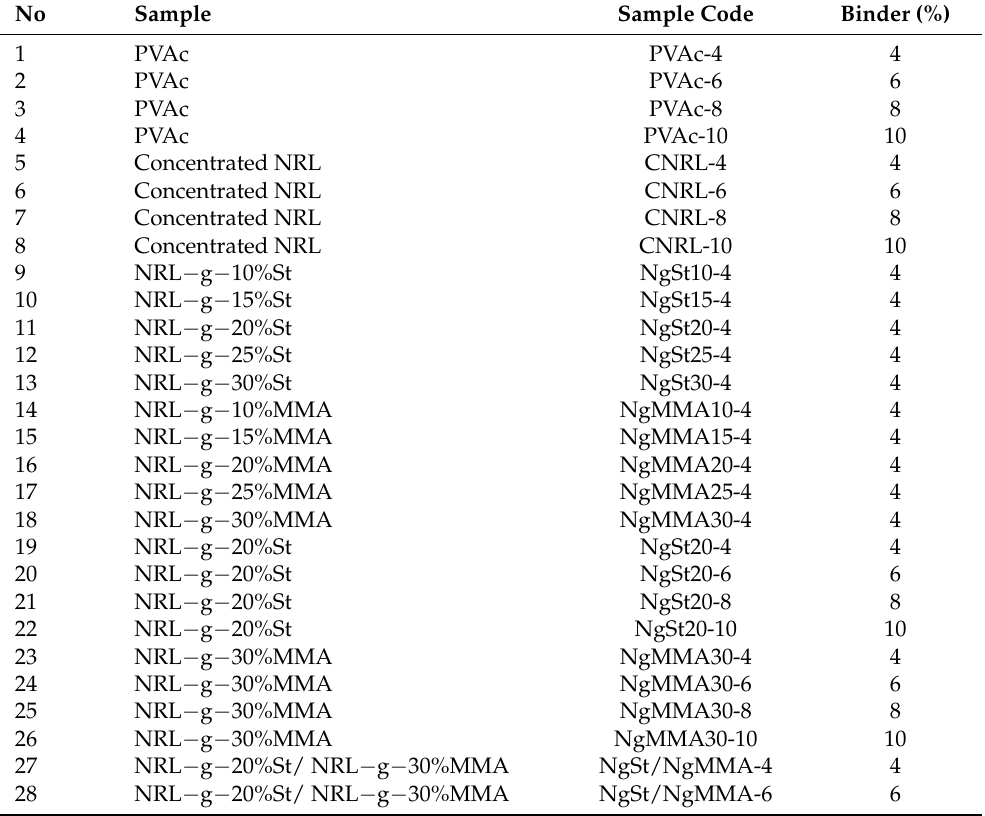
Table 3. Samples and Sample Codes Based on Variations in Binder